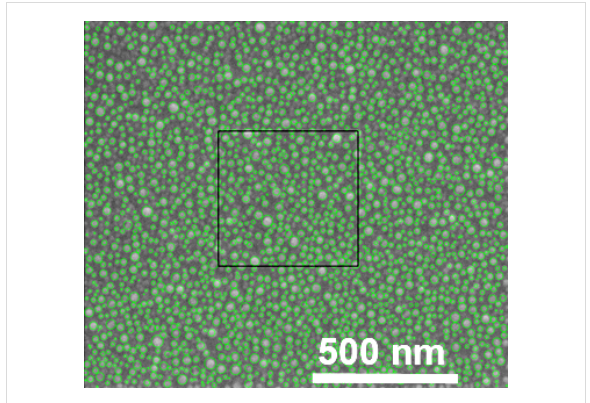
Figure 11: SEM image of the gold nanoislands on the silicon sub- strate (sample 2.8 nm Au film on Si(111) substrate after annealing at 550 °C for 15 min). Green circles indicate the recognized structures. A sample of 0.5 μ m × 0.5 μ m size (marked by the black frame) was used for the simulations.